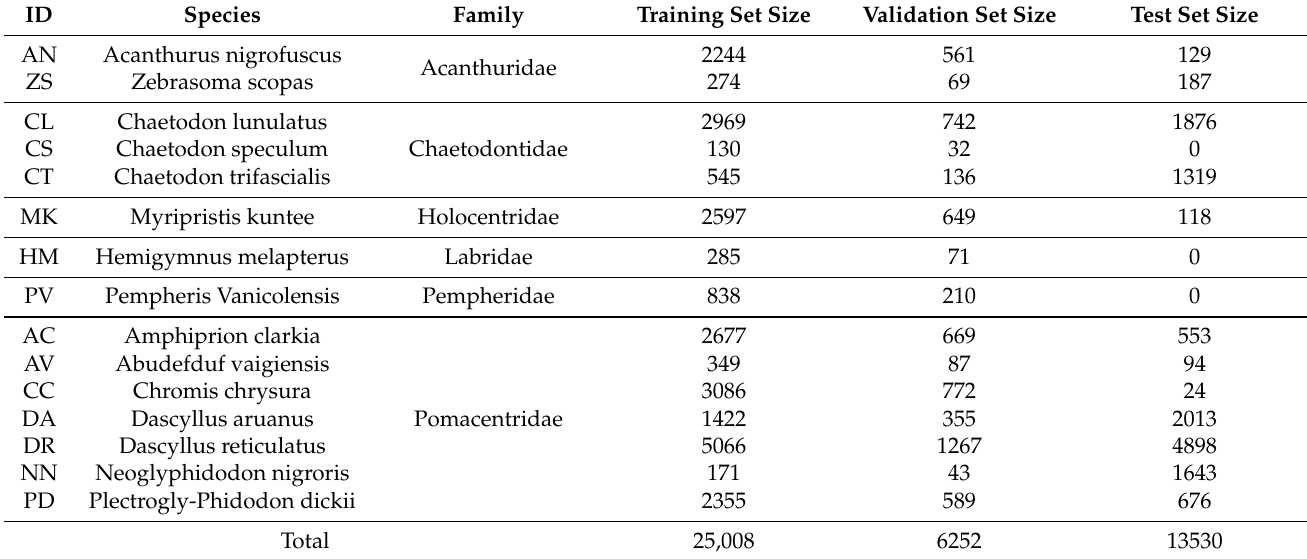
Table 2. The fish species distribution in the LCF-15